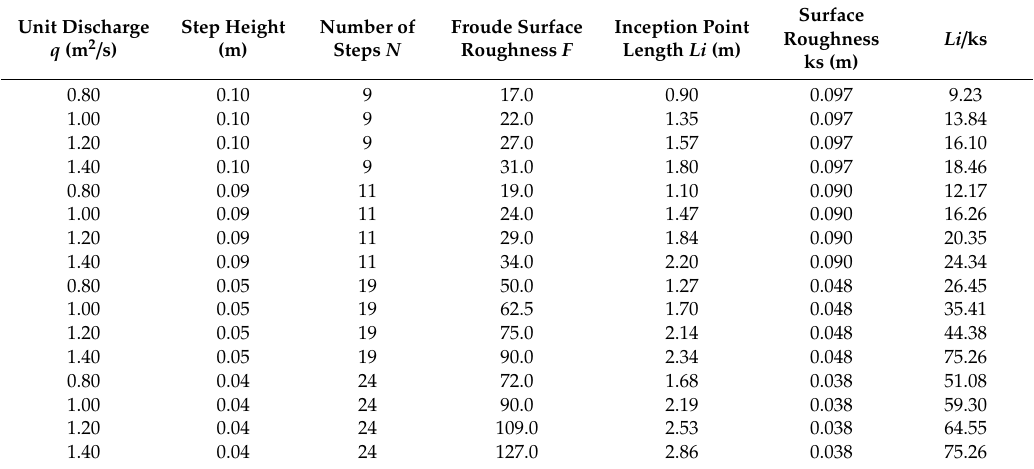
Table 2. Summary of unit discharge ( q ), step height, Froude surface roughness ( F ), inception point length ( Li ), surface roughness (ks) and normalized ( Li ).